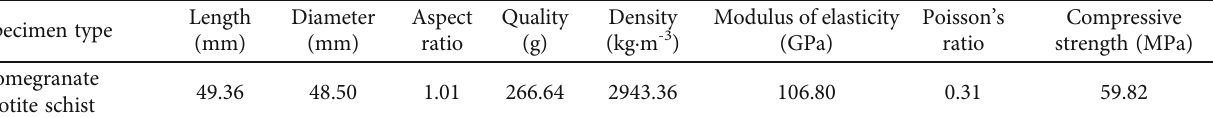
Table 1: Average values of physical parameters of specimens.